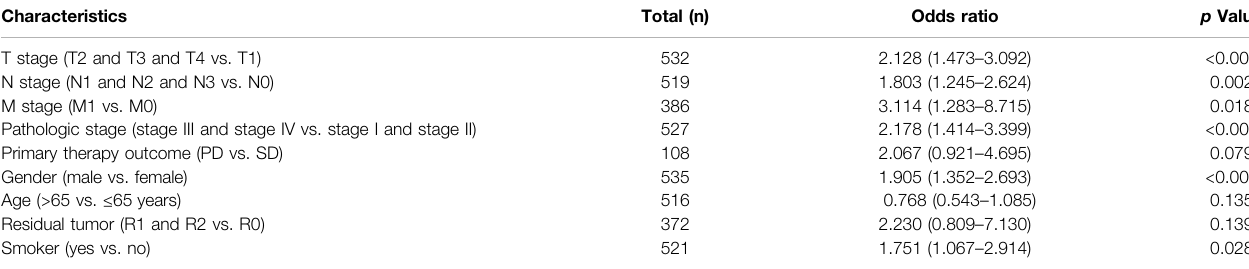
TABLE 1 | Logistic regression analysis of correlation between clinical – pathological characteristics and NCAPG expression in NSCLC patients. Characteristics p Value T stage (T2 and T3 and T4 vs. T1) < 0.001 N stage (N1 and N2 and N3 vs.